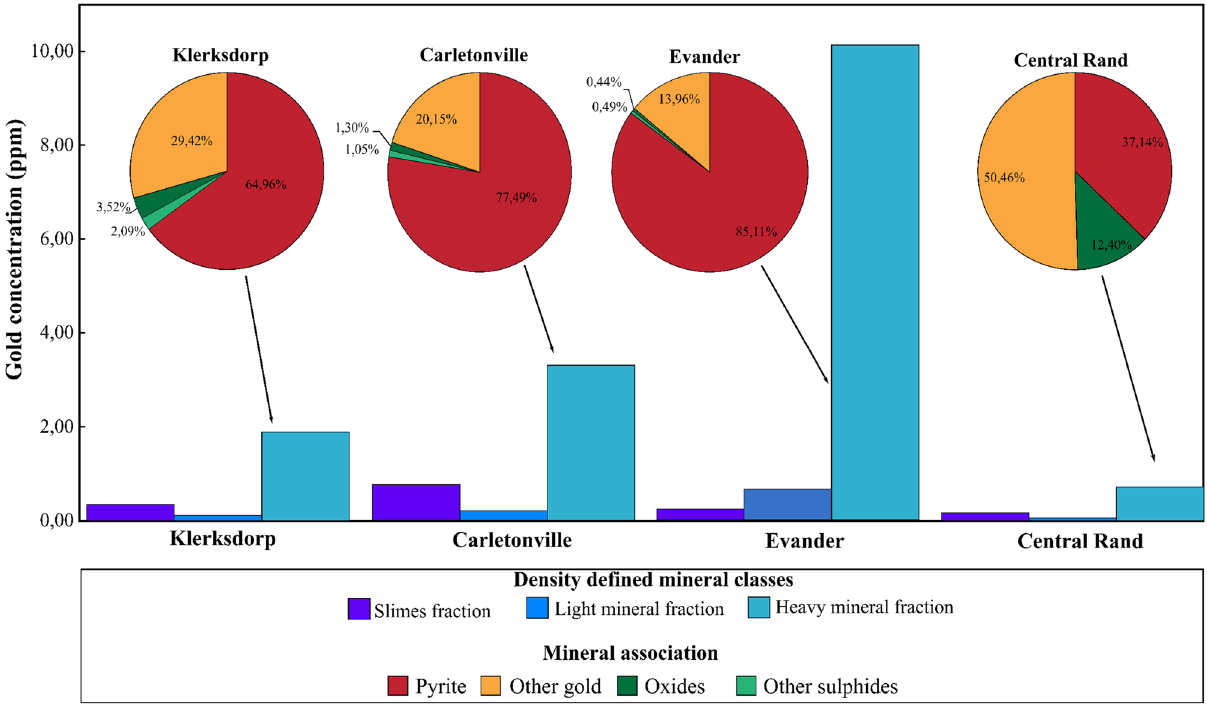
Figure 2. A bar graph showing the gold concentration and mass percentages within each of the density- defined operational mineral fractions from the corresponding goldfield tailings dump material. The pie charts display the distribution of gold by mineralogy within the heavy mineral fraction of the tailings material. Other sulphides refer to arsenopyrite, galena, sphalerite, chalcopyrite, pentlandite and pyrrhotite. Oxides refer to hematite, magnetite, and limonite/goethite. The other gold may represent sub-microscopic free grains, gold that is associated with minerals that were not analysed using LA ICP-MS or a manifestation of the error propagation through the mass balance